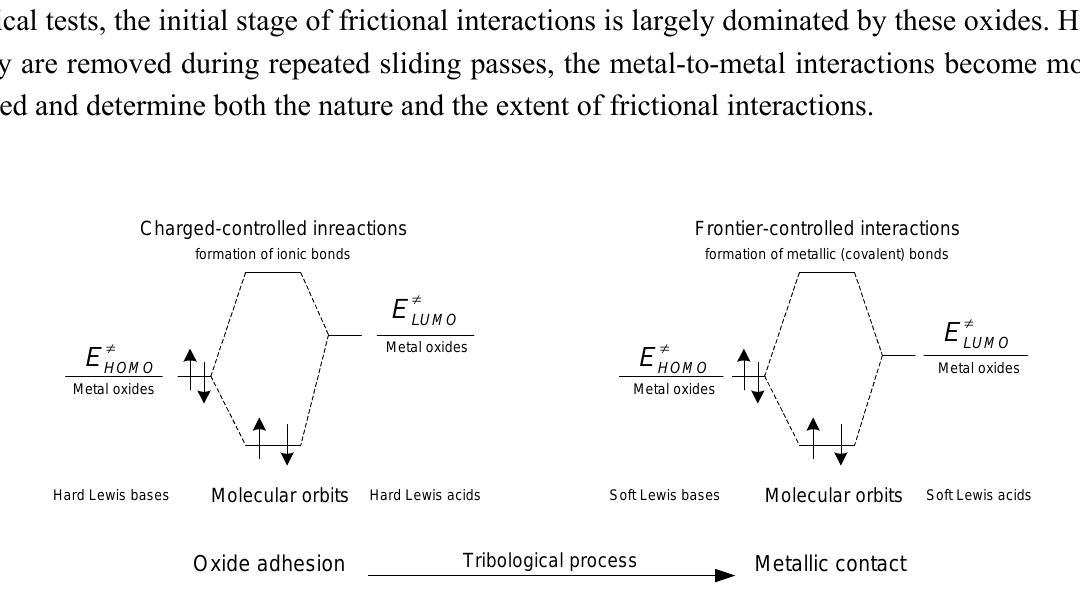
Figure 4. A molecular orbital theory account of tribological mechanisms of ionic solid